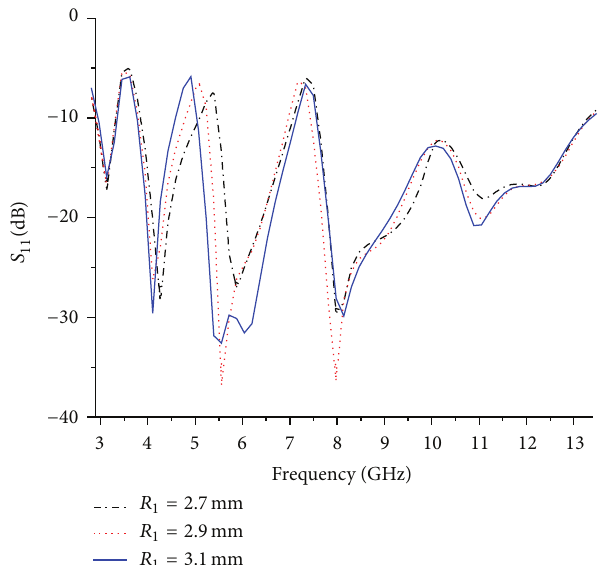
Figure 4: The effect of 𝑅 1 on 𝑆 11 of the proposed antenna.